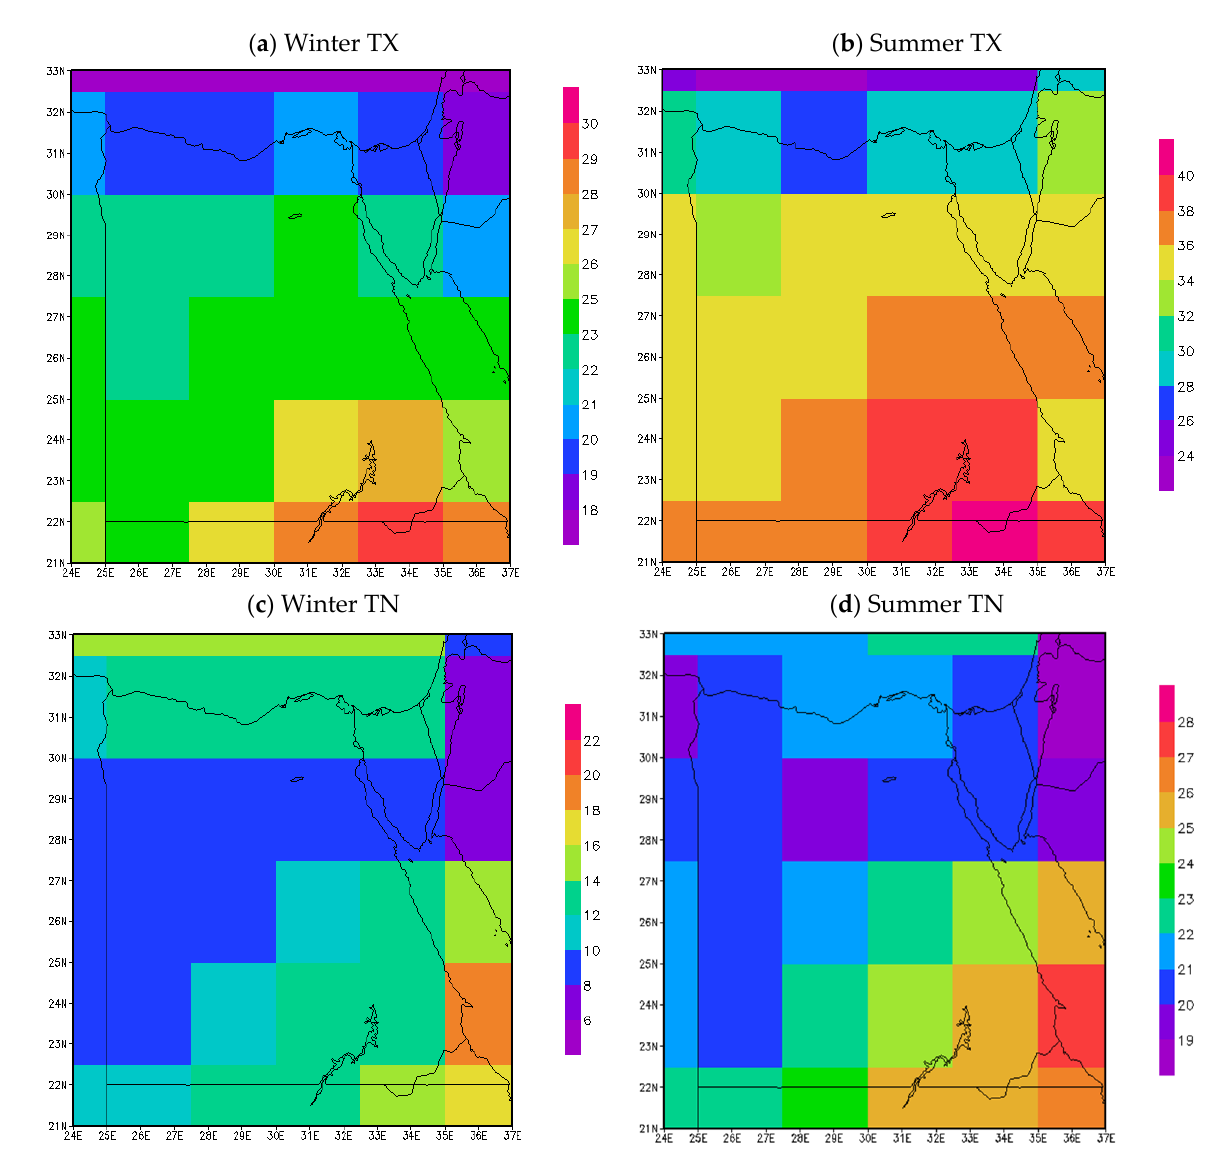
Figure 2. The seasonal mean temperature for the period (1986–2005), ( a ) winter (Nov-Apr) maximum temperature (TX), ( b ) summer TX (May-Oct), ( c ) winter minimum temperature (TN), and ( d ) summer TN.